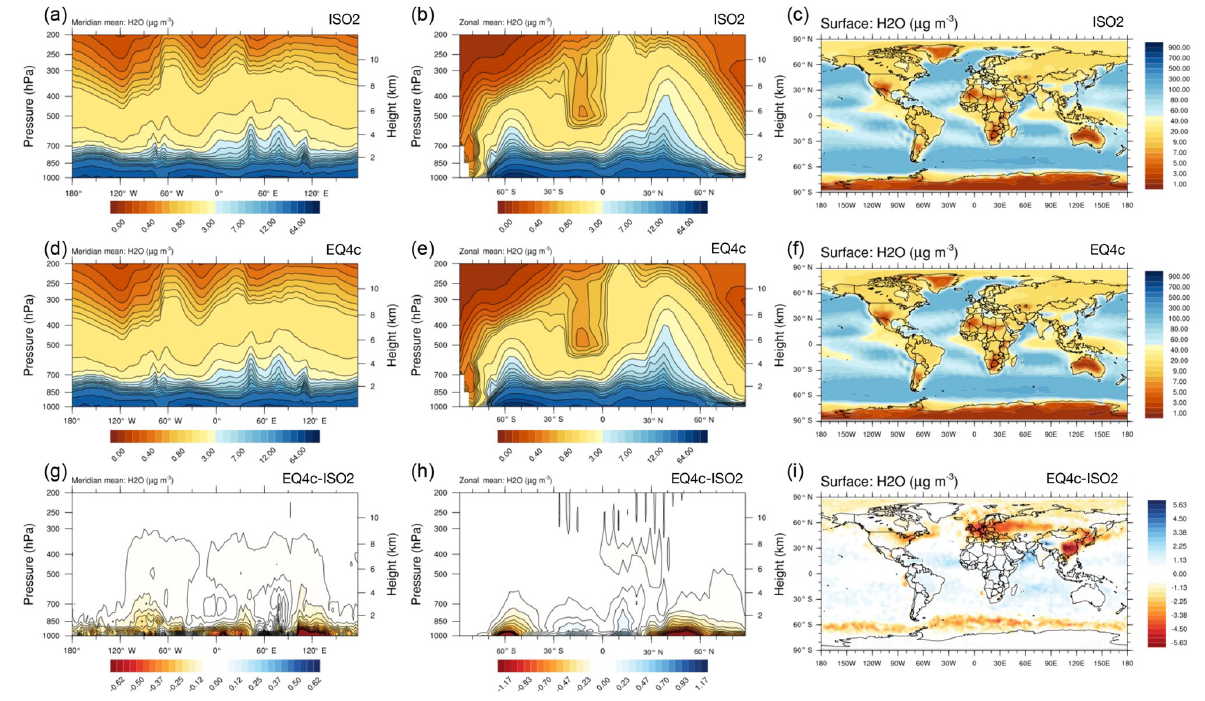
Figure 8. Figure 7 continued for EMAC aerosol-associated water (2000–2013 mean). Please note the inversion of the color scale (compared to Fig.